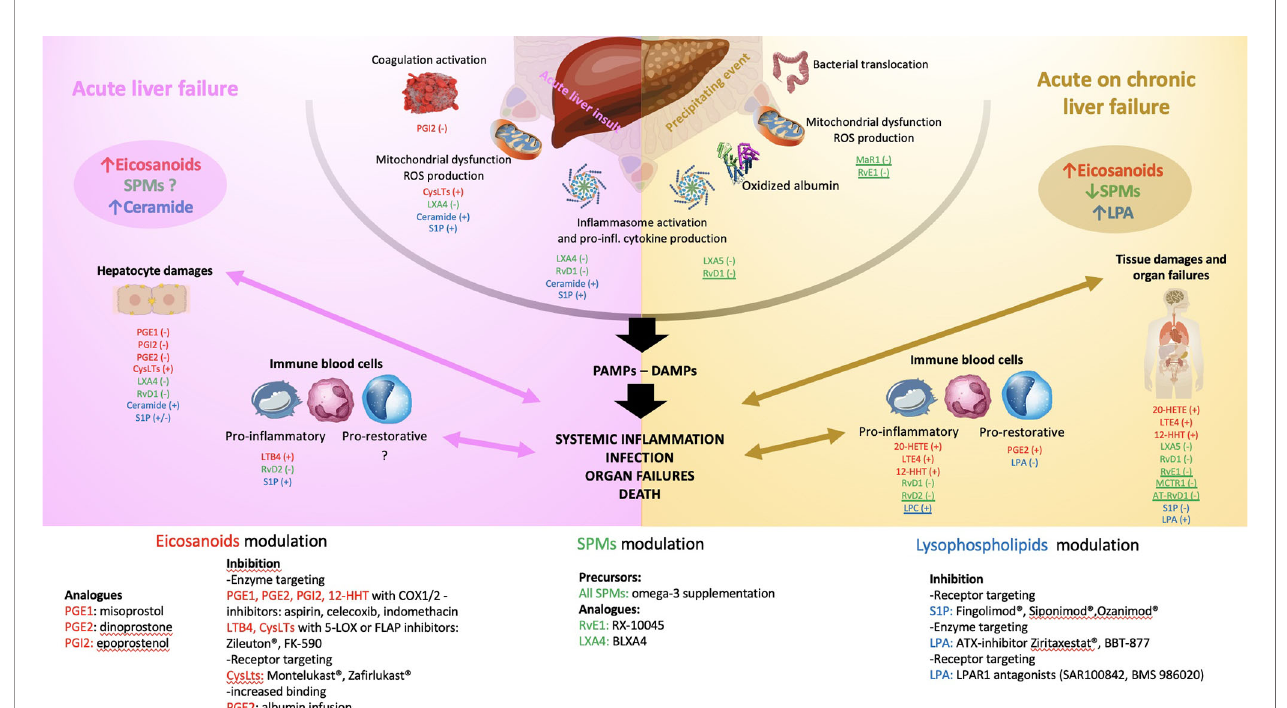
FIGURE 2 | Schematic illustration of the pathophysiology of acute liver failure (ALF- left panel) and acute on chronic liver failure (ACLF - right panel). The main endogenous bioactive lipids are identi fi ed with colours: eicosanoids in red, specialized pro-resolving lipid mediators (SPMs) in green, lysophospholipids in blue. Reported effects of the underlined mediators illustrate only investigation in sepsis models. Left panel: ALF starts with an acute liver insult (viral, toxic, ischemia, traumatism) occurring on a healthy liver leading to the release of danger-associated molecular patterns (DAMPS), in fl ammasome activation and secretion of pro-in fl ammatory cytokines and chemokines, coagulation activation and mitochondrial dysfunction leading to the release of reactive oxygen species (ROS). In ALF, a global increase in eicosanoids mediators and ceramide has been reported while the global trend of SPMs level is not known. The consequences are mainly those of perpetuating hepatocytes damages (cell death by necrosis, apoptosis, defect in liver regeneration aggravated by resident macrophages activation) and activation of circulating immune compartment through a pro-in fl ammatory phenotype (bacterial killing with phagocytosis, secretion of pro-in fl ammatory signals favouring leukocytes recruitment and tissue in fi ltration). A switch to a pro-restorative phenotype (decreased bacterial killing capacity and phagocytosis, increased efferocytosis function) occurs during the disease course exposing leading to systemic immunosuppression. All together these mechanisms lead to severe systemic in fl ammation and when uncontrolled infection, multi-organ failures and death. The effect investigated in experimental and translational studies of each lipid mediator is reported. (+) or (-) corresponds to its action on the pathophysiologic step (e.g., PGE1 decreases the hepatocytes damages in experimental models of ALF). Right panel: ACLF starts with a precipitating event (e.g., alcoholic hepatitis, infection, drug-induced liver injury, hepatitis B reactivation, gastrointestinal bleeding), occurring on a chronically affected liver. This leads to an increase in bacterial translocation, mitochondrial dysfunction with the generation of ROS and pro-in fl ammatory oxidized form of albumin, in fl ammasome activation and secretion of pro-in fl ammatory cytokines and chemokines. In ACLF, a global increase in eicosanoids mediators and LPA and a decrease in SPMs and LPC levels has been reported. The consequences are mainly a release of pathogen-associated molecular patterns (PAMPs) and DAMPs leading to intense systemic in fl ammation. The circulating immune compartment can be either pro-in fl ammatory or pro-restorative favouring infection, organ failures and death. As for the left panel, the effect investigated in experimental and translational studies of each lipid mediator is reported. (+) or (-) corresponds to its action on the pathophysiologic step (e.g., PGE2 favours the pro-restorative phenotype of the immune cell compartment). The bottom of the fi gure reports the different molecules that were clinically shown to modulate the action of the lipid mediator reported in the left and right panels. ATX, autotaxin, C1P, ceramide-1-phosphate; COX, cyclooxygenase; CysLTs, cysteinyl leukotrienes; DAMPs, danger-associated molecular patterns; FLAP, 5-LOX activating protein; LTB4, leukotriene B4; LOX, lipoxygenase; LPA, lysophosphatidic acid; LPAR, lysophosphatidic acid receptor; LPC, lysophosphatidylcholine; LX, lipoxin; MaR, maresin; MCTR1, maresin conjugates in tissue regeneration 1; PAMPs, pathogen- associated molecular patterns; PG, prostaglandin; RvD, D-series resolvin; RvE, E-series resolvin; S1P, Sphingosine-1-phosphate; S1PR, Sphingosine-1-phosphate receptor; SPMs, specialized pro-resolving